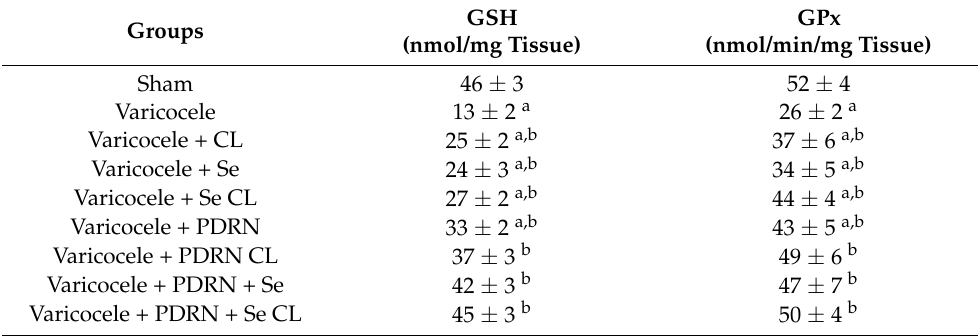
Table 2. Effects on glutathione (GSH) and glutathione peroxidase (GPx) as induced by Se (0.4